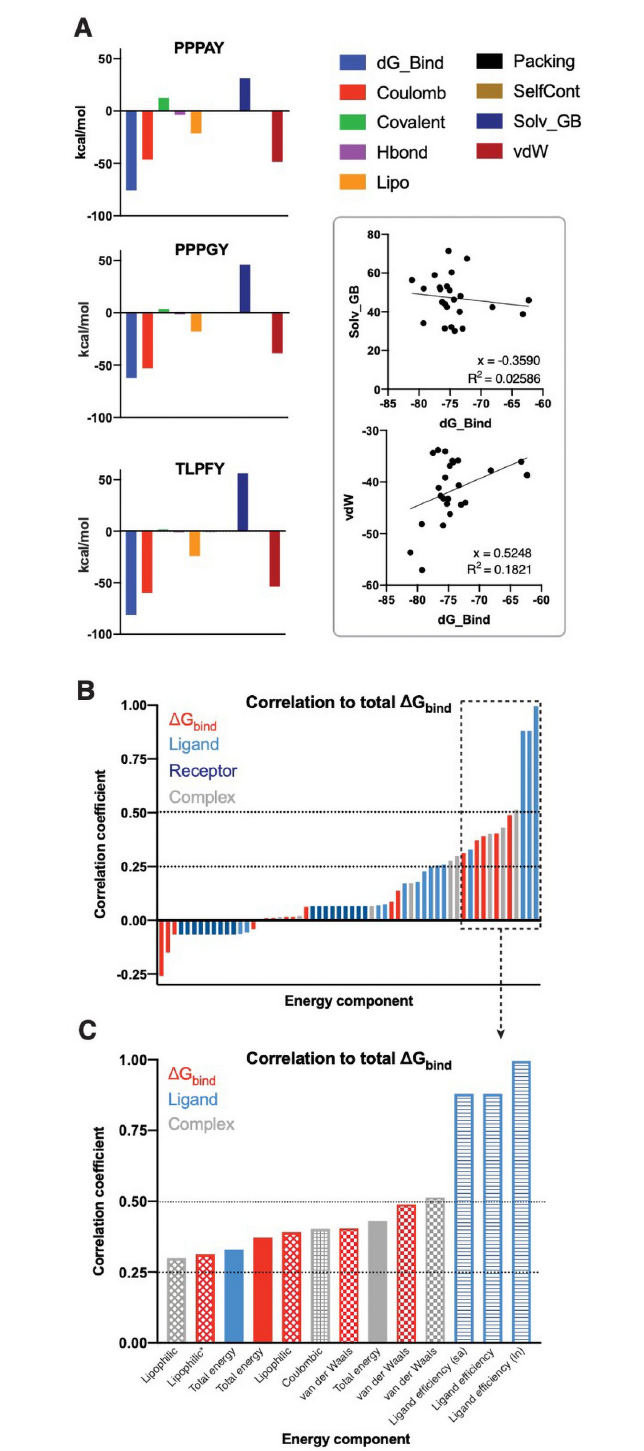
Fig 7. Individual biomolecular interaction types have varying contributions to overall binding affinity. (A) Energetic contributions of individual interactions to overall binding affinity are shown for the native ligand (PPPAY), a weaker predicate binder (PPPGY), and a stronger predicted binder (TLPFY). Linear regression analysis reveals a positive and negative correlation, respectively, between van der Waals forces or solvation energy with overall binding energy ( Δ G binding ). (B) Analysis of all individual energy components (for Δ G bind , the optimized complex, ligand, and